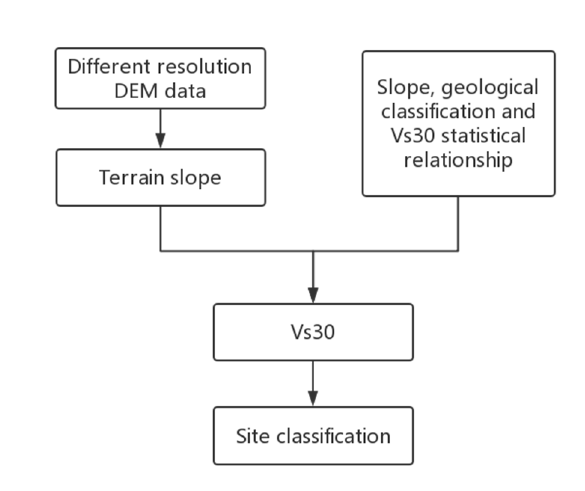
Figure 1. Flow chart of site classification calculation